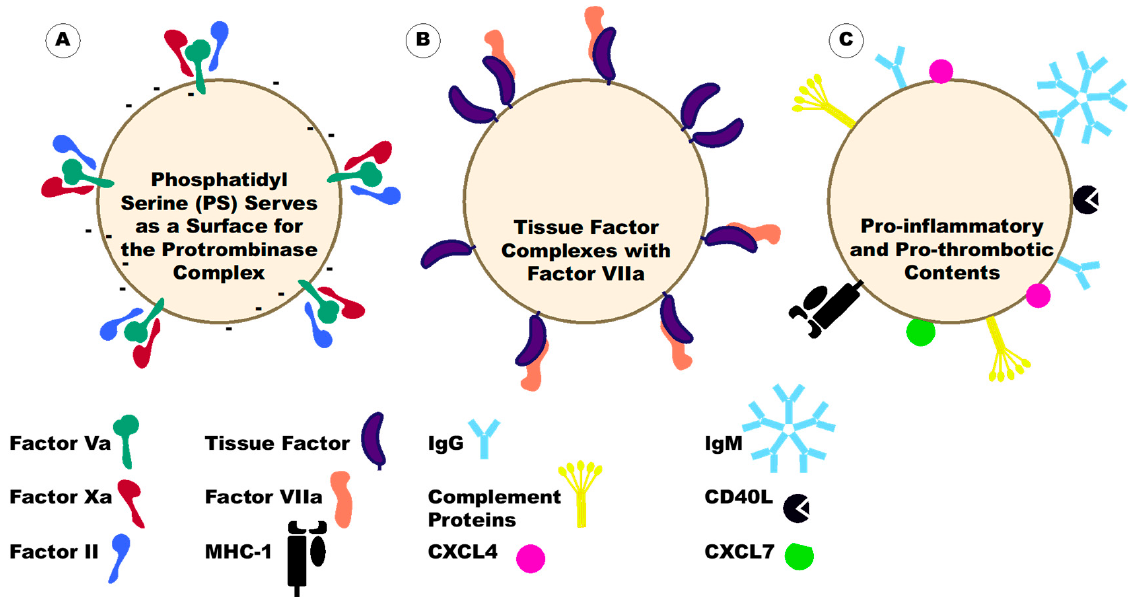
Figure 5. Mechanisms by which Extracellular Vesicles (EVs) can Contribute to Thrombosis. There are three known pathways through which EVs can influence thrombosis: ( A ). Phosphatidylserine on the surface of EVs provides a negatively charged surface on which the prothrombinase complex (comprised of factors Va, Xa, and II) can form, ( B ). Tissue factor (TF) on EVs interacts with factor VIIa to initiate the coagulation cascade, ( C ). Molecules such as clotting factors, MHC-1, complement proteins, CXCL4, CXCL7, CD40 ligand (CD40L), and immunoglobulins (IgG and IgM) on the vesicle